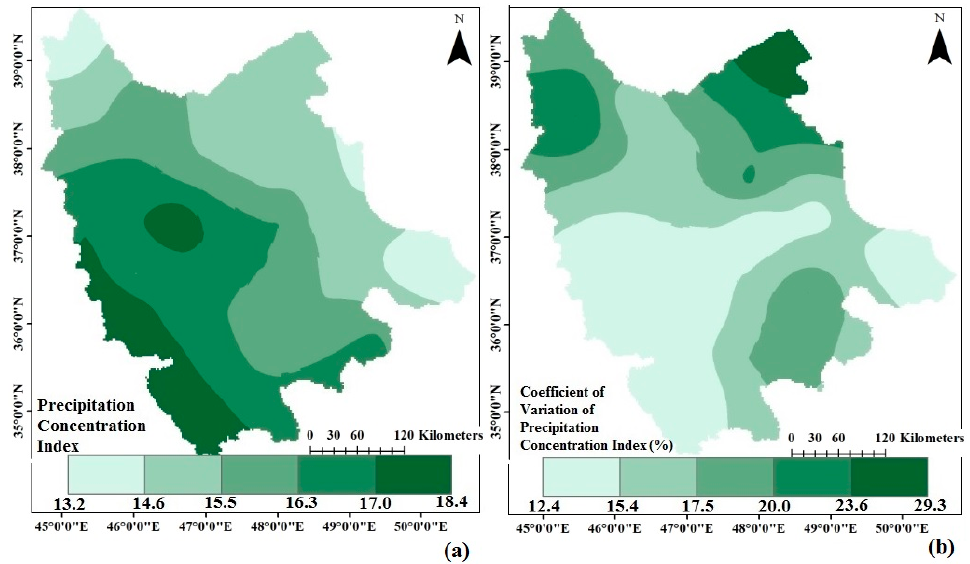
Figure 4. Spatial patterns of ( a ) precipitation concentration index (PCI); and ( b ) Coefficient of variation of PCI.